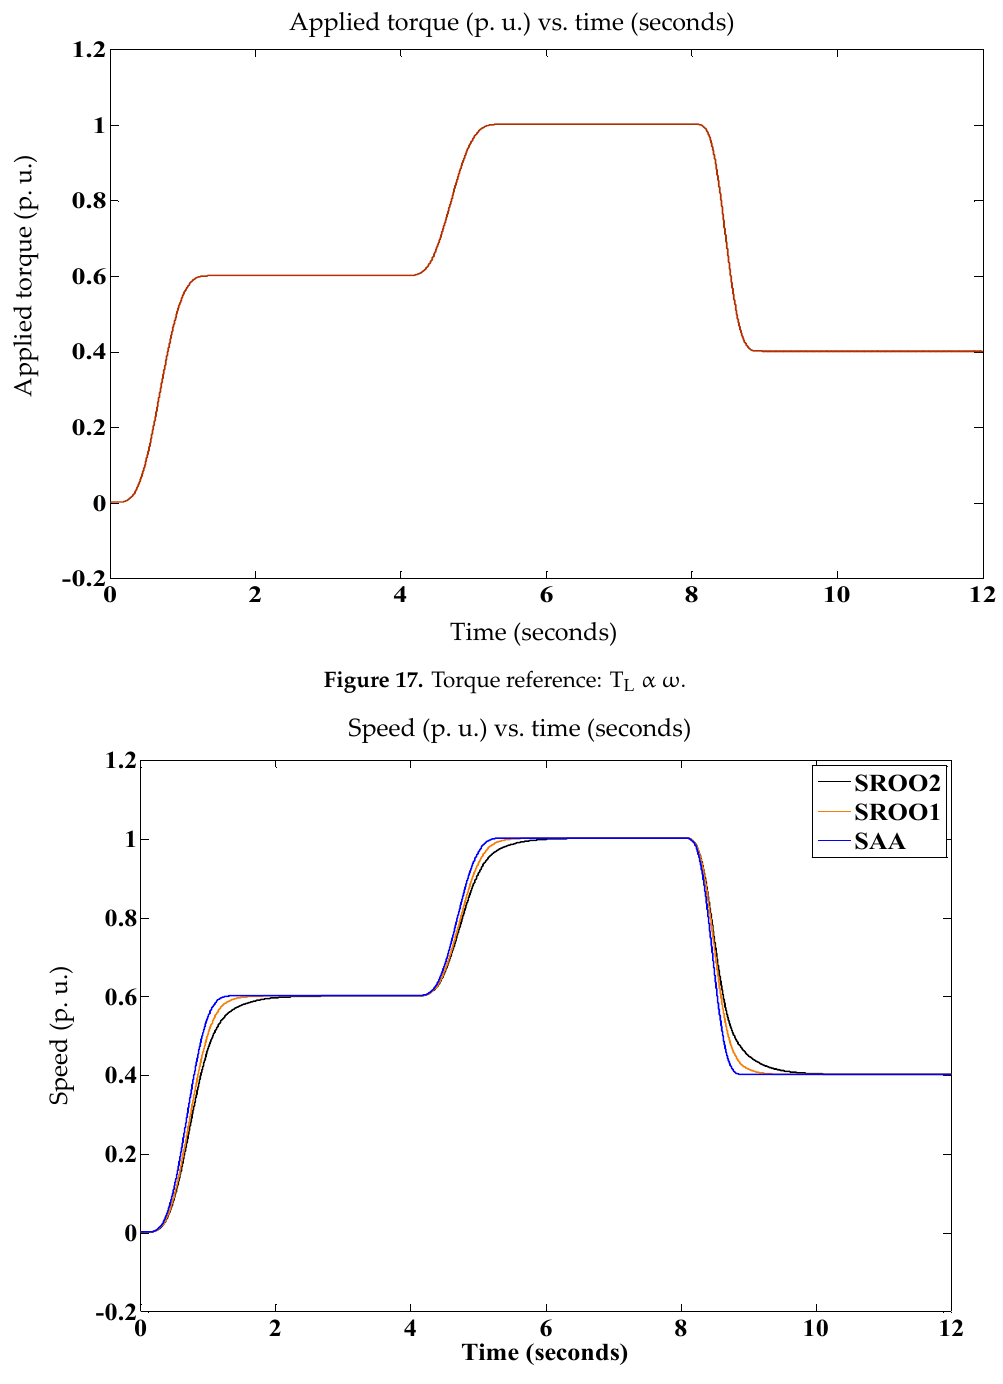
Figure 18. Measured speed of the DC motor: T L α ω .